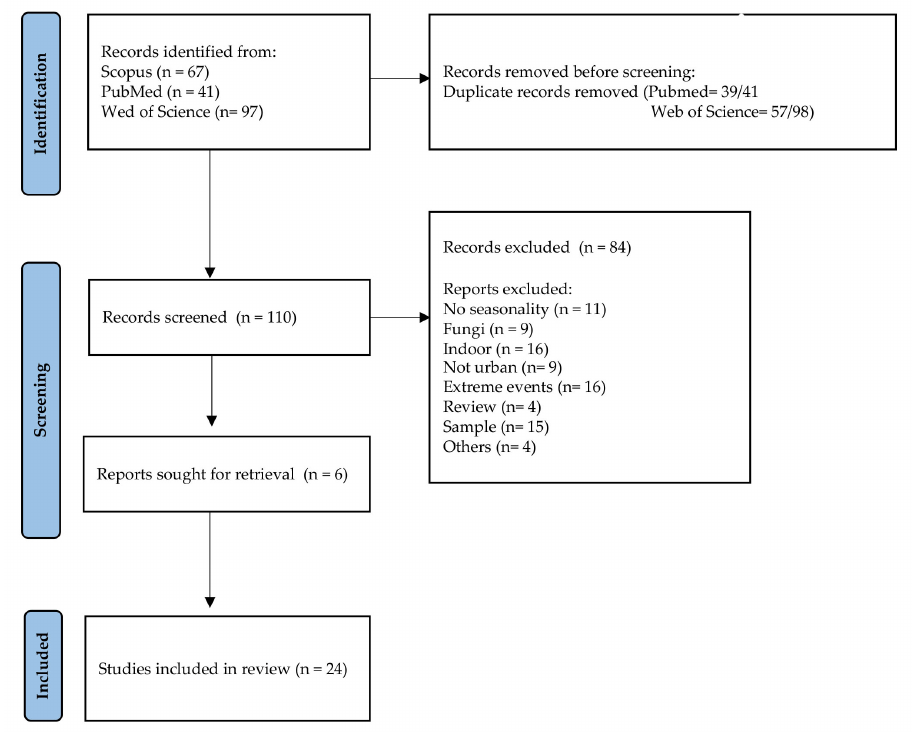
Figure 1. Flow diagram of the systematic review steps following the PRISMA 2020 statement [33].